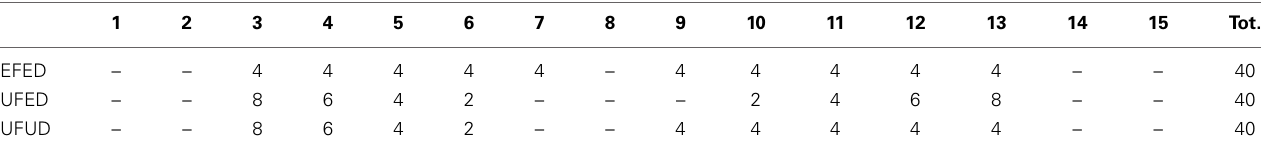
Table 1 | Stimulus Frequencies for Training Session in Experimental Conditions for equal frequency, even distributions (EFED), unequal frequency, even distributions (UFED), and unequal frequency, uneven distributions